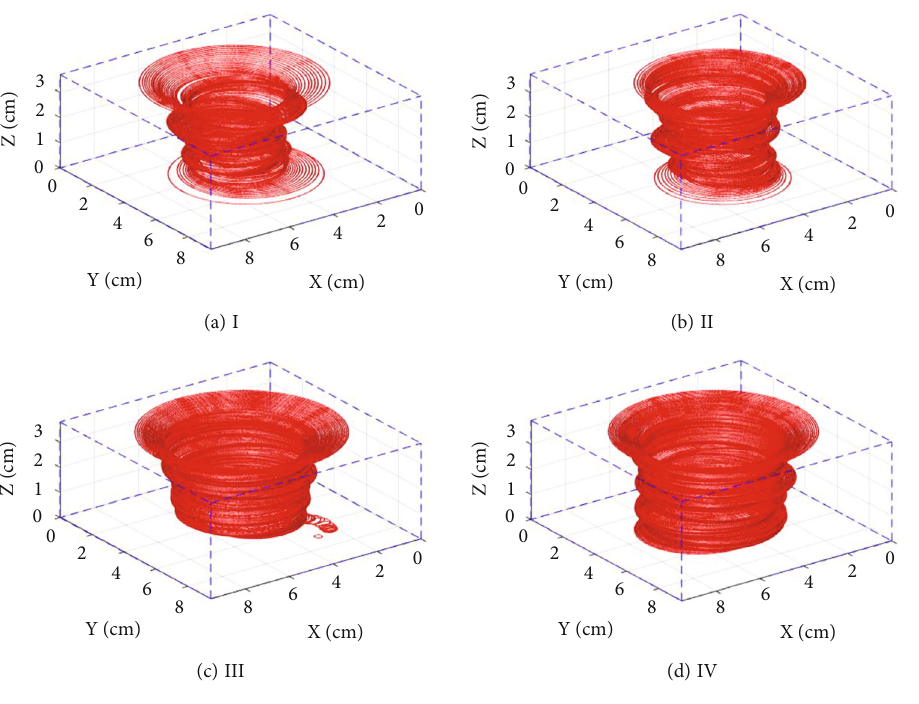
Figure 9: Equivalent drainage